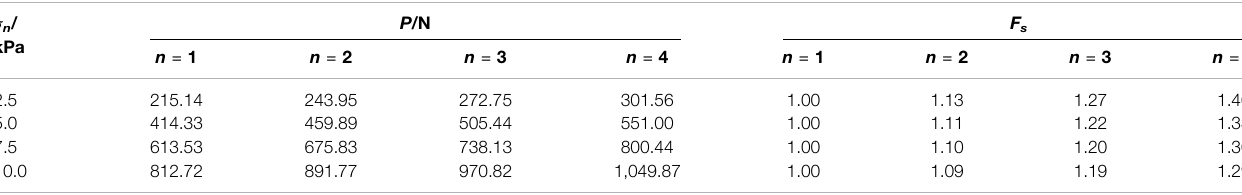
TABLE 5 | The pullout force and scale factor under different